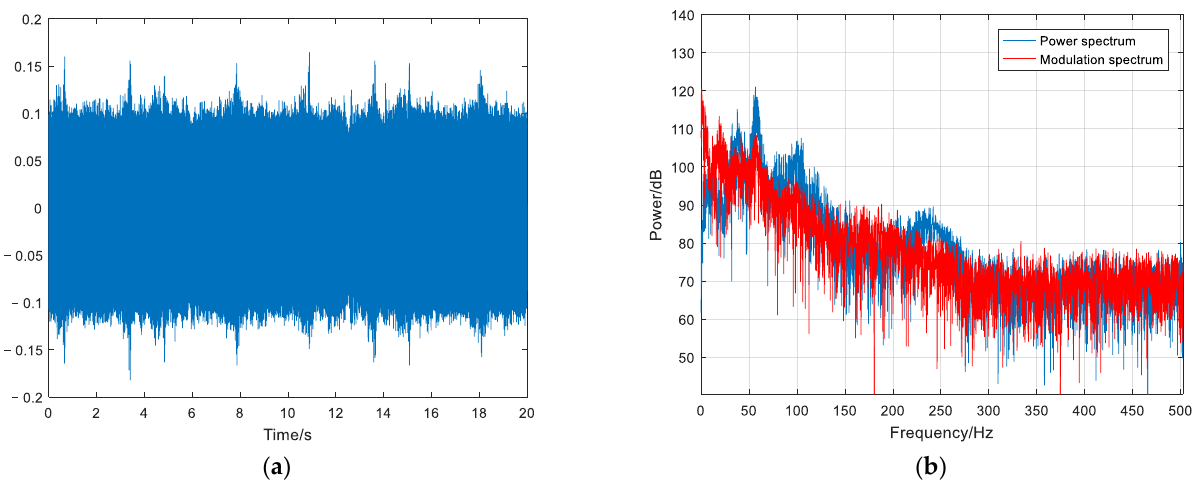
Figure 12. The time domain diagram and frequency domain diagram of the receiving data: ( a ) the time domain diagram of the receiving data; ( b ) the frequency domain diagram of the receiving data.